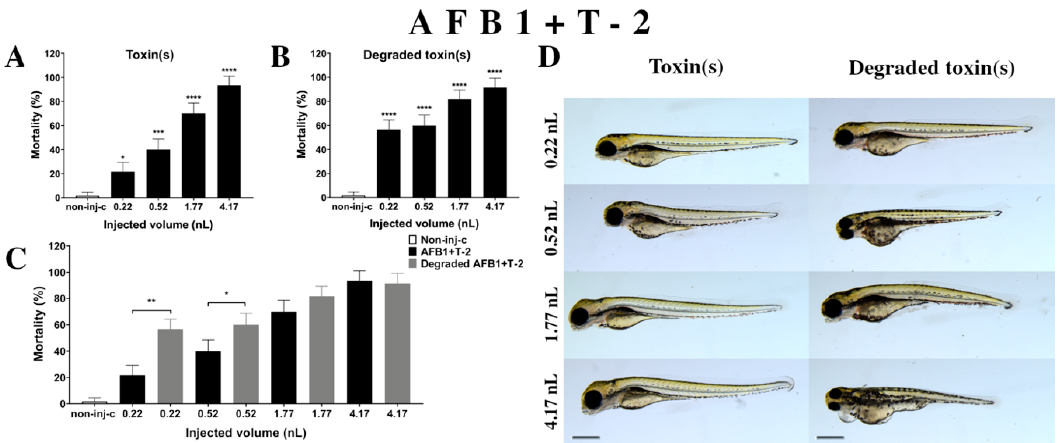
Figure 6. Effects of AFB1+T-2 mixture ( A ) and their degradation products ( B ) by the Rhodococcus erythropolis NI1 strain on 120 hpf zebrafish embryos. Mortality data are expressed as mean ± SD from three independent experiments in triplicate. Kruskal–Wallis followed by Dunn’s post-hoc test and Mann–Whitney test were used. Mortality values were compared to the non-injected control (non-inj-c) (* p < 0.05, *** p < 0.001, **** p < 0.0001); lethality results of the initial AFB1+T-2 were compared to the degradation products of the AFB1+T-2 mixture ( C ) (* p < 0.05, ** p < 0.01). AFB1+T-2 and their degradation products induced developmental dysfunctions ( D ) in zebrafish embryos examined at 120 h. Representative phenotypic lesions of AFB1+T-2 were tail deformities, head and lens distortion, and swim bladders were not developed at either dose; sublethal effects of their degradation products were tail deformities, pericardial and yolk edema, head and lens distortion, and swim bladders were not developed at either dose. Scale bar: 1 mm. Phenotypes of treated groups were compared to the non-injected control (non-inj-c) (Figure 1C). Quantitative data of developmental dysfunctions in zebrafish embryos are in the Supplementary Materials (Supplementary Table